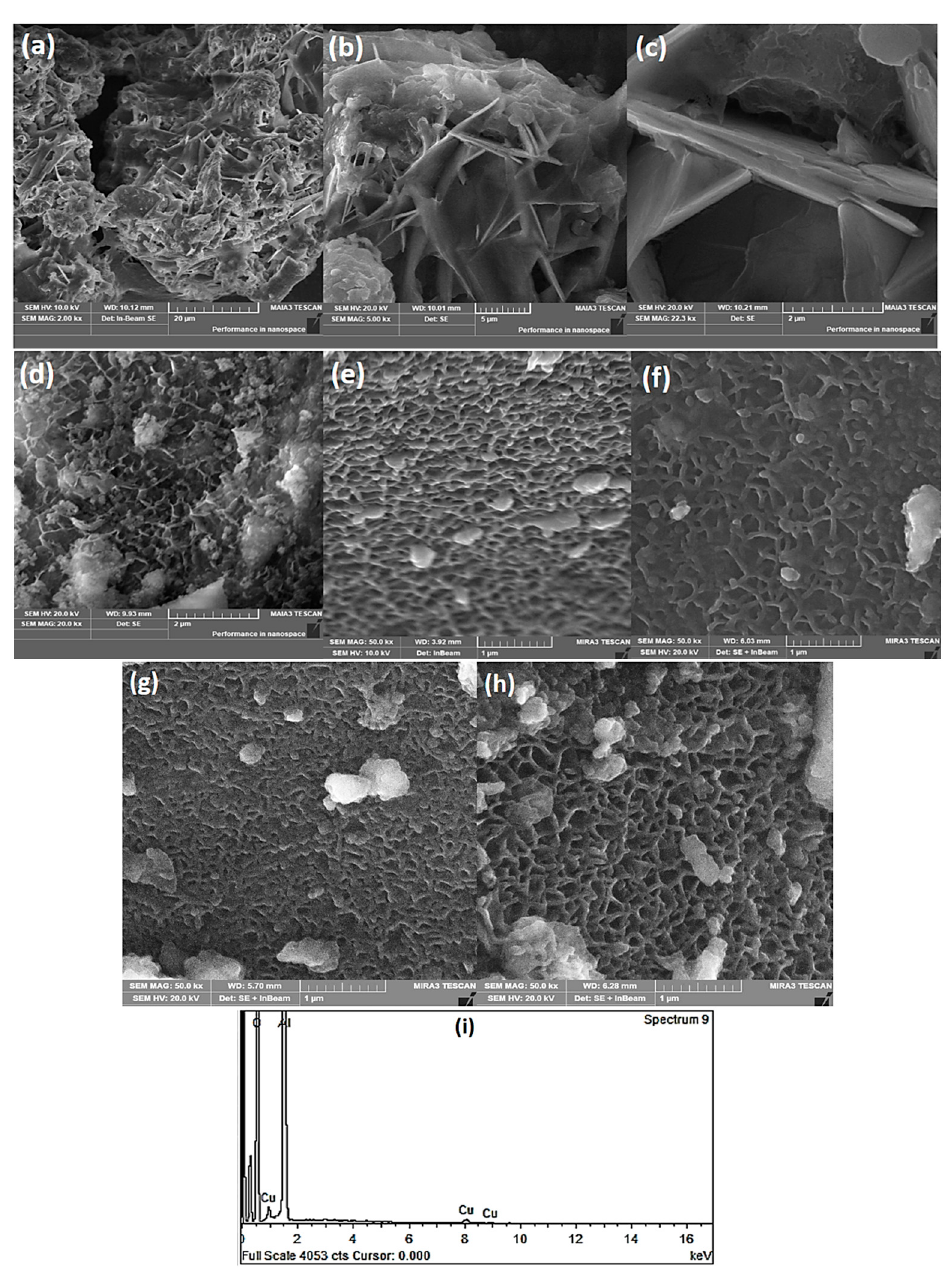
Figure 3. SEM micrographs for pure Al 2 O 3 at 20 μ m ( a ), 5 μ m ( b ) and 2 μ m ( c ) and for 4%–20%-CuO/ γ -Al 2 O 3 materials respectively at 1 μ m ( d – h ) and ( i ) Energy dispersive spectrum for 4%-CuO/ γ -Al 2 O 3 .